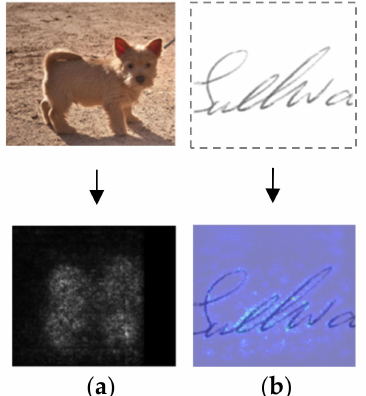
Figure 2. Saliency maps for the predicted class. ( a ) Dog and its saliency map marked by grayscale (taken from [5]); ( b ) signature and its saliency map marked by jet-colormap (taken from our